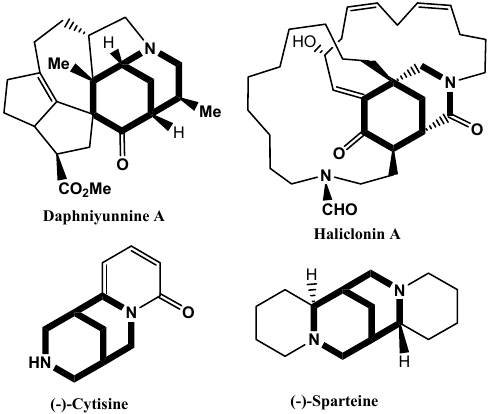
Figure 1. Azabicyclo[3.3.1]nonane-based natural products.